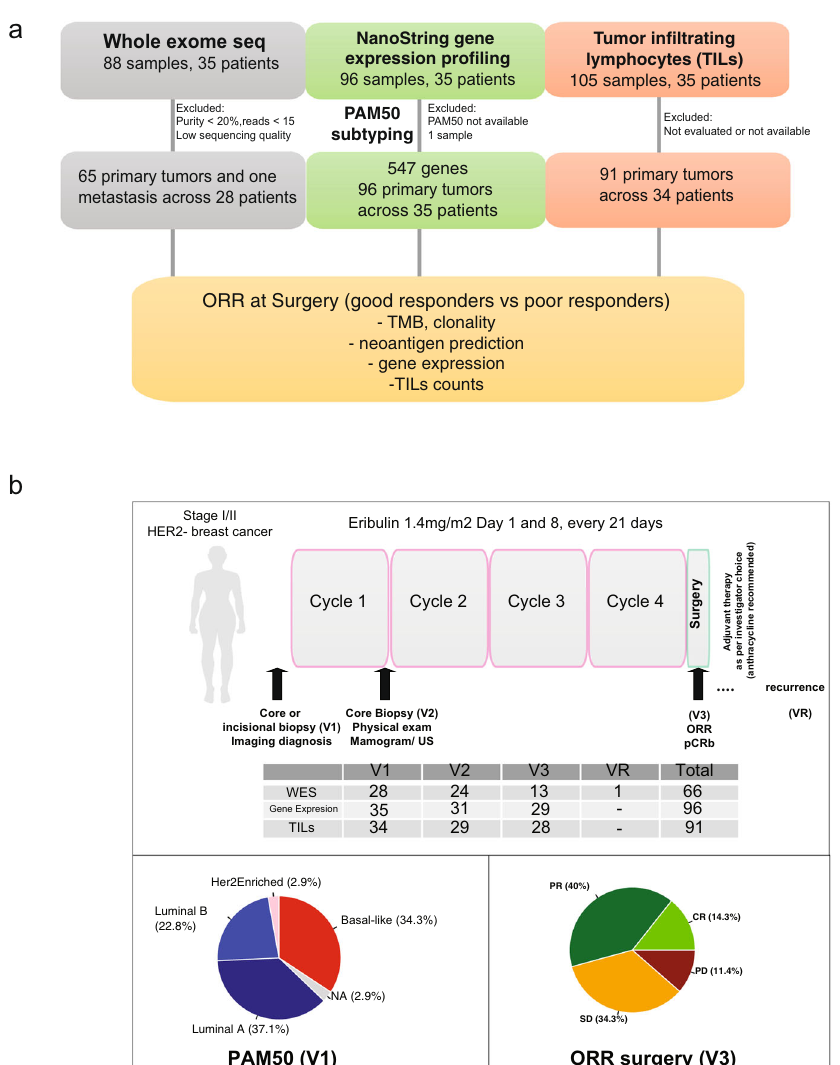
Fig. 1 The study schematics. a . Tumour tissue samples underwent (i) Whole-exome sequencing (WES) for mutation and clonality detection followed by neoantigen prediction; (ii) Nanostring gene expression pro fi ling; and (iii) stromal TILs counting. Our goal was to select samples that passed quality control and perform the temporal characterisation of the mutational, gene expression and TILs in serial primary HER2- negative breast cancers that were good responders or poor responders to eribulin. DNA sequencing (WES) was performed in 88 primary invasive breast cancers and matched the normal DNA of each patient. Of these, 66 tumour samples were used for mutational and clonality analyses. RNA-Nanostring gene expression pro fi ling was performed in 96 primary invasive breast cancers. From the DNA sequencing data, candidate neoantigens were predicted. Stromal TILs were counted from the H&E slides in 91 out of 105 tumour specimens. Clinical features and the PAM50 intrinsic molecular subtypes of each of the sequential primary tumour ’ s biopsies were examined. TMB tumour mutation burden, ORR overall response rate. b Schematics of the clinical trial. Temporal tumour sampling and a number of samples included in each analysis and time point are depicted. Distribution of PAM50 molecular intrinsic breast cancer subtypes at V1 (diagnostic biopsy), and ORR at V3 (surgery). E eribulin administration, V1 visit one, V2 visit two, V3 visit three, VR visit recurrence, CR complete response, PR partial response, SD stable disease, PD progressive